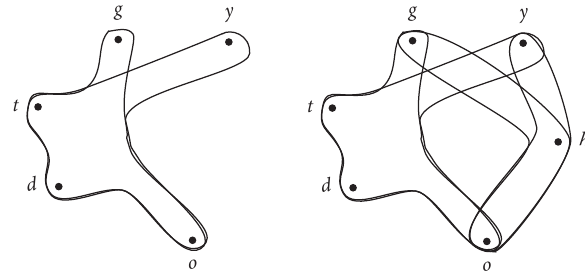
Figure 3: Rough hypergraph (( φ A, ψ D ) , ( φ A, ψ D ))